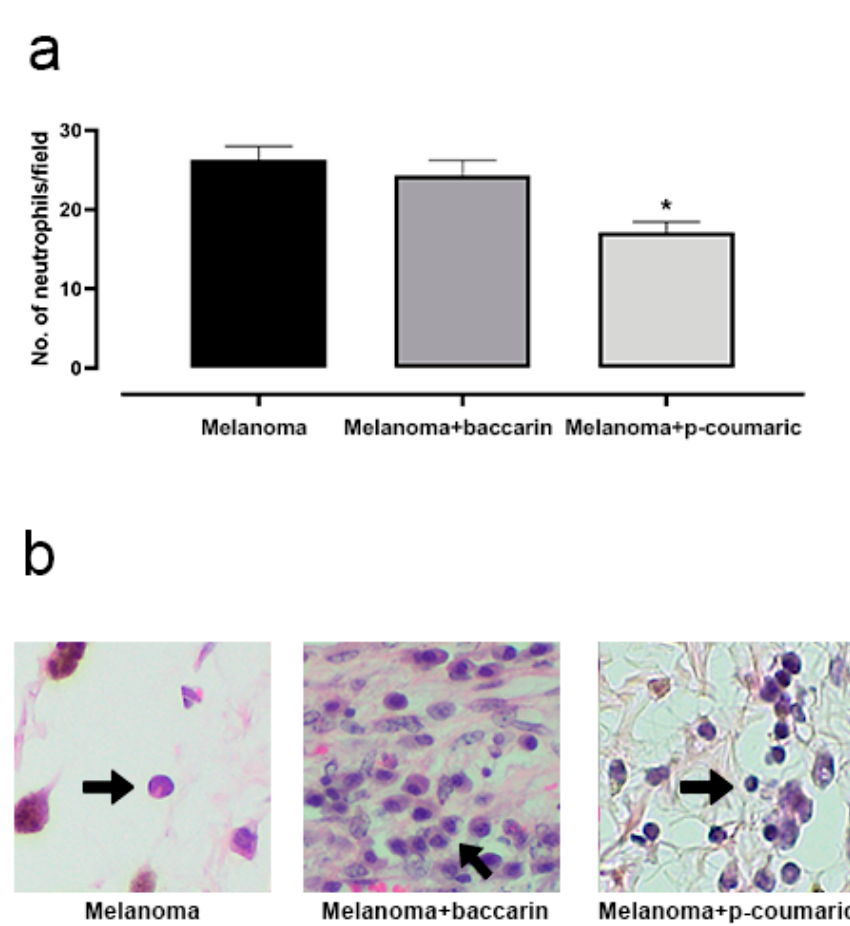
Figure 4. ( a ) Representative graphic of the tumor neutrophils analysis. The tumor induces an increase in neutrophils. Comparison between the Control and Melanoma groups (B16F10 concentration of 10 6 cell/mL) that ingested only PBS and the baccharin and Melanoma + baccharin, who received treatment with the baccharin compound (500 µ g/kg) for 26 days. However, in the comparison between the Control and Melanoma groups (B16F10 concentration of 10 6 cell/mL) that ingested only PBS and the p-coumaric and Melanoma + p-coumaric acid groups that received treatment with the compound for 26 days, there was a significant reduction ( p < 0.05) in the recruitment of these cells. ( b ) Representative images of the histological section in 200x magnification. Data represents mean ± SEM. * These differences were considered significant with p < 0.05.